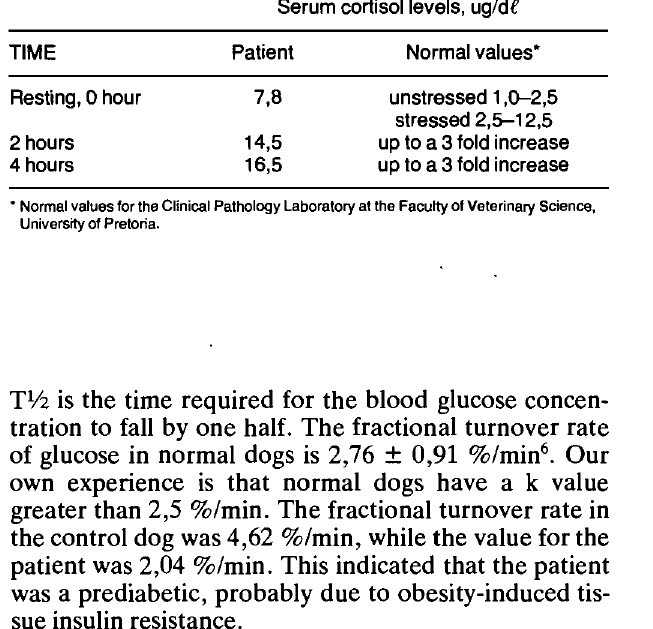
Table 2: SERUM THYROID HORMONE LEVELS Parameter, units